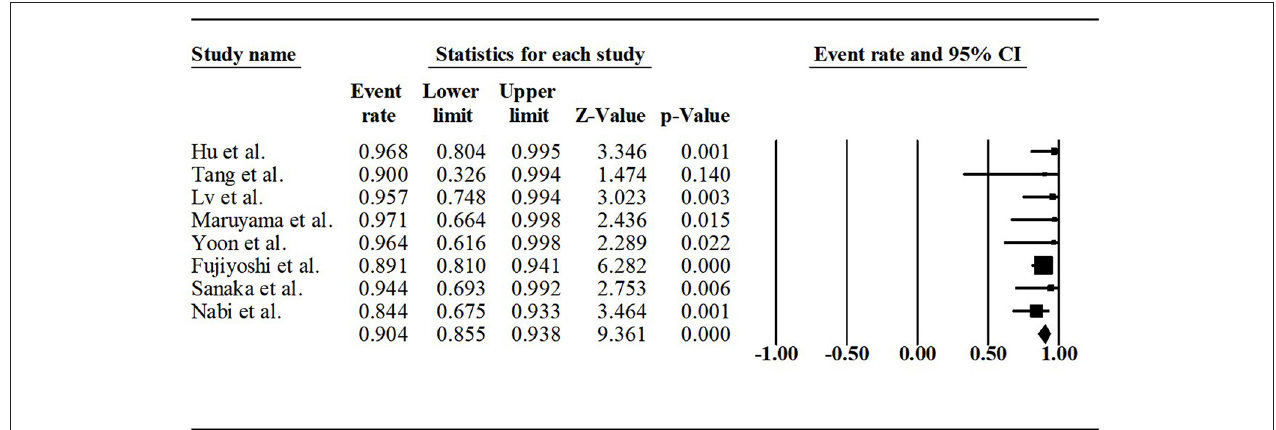
FIGURE 2 | Forest plot of clinical success of POEM for sigmoid-type achalasia.